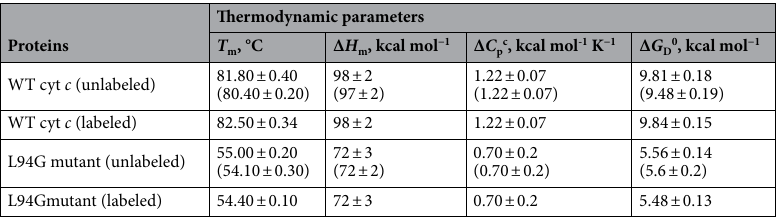
Table 3. Thermodynamic parameters associated with the heat-induced denaturation of WT cyt c and its L94G mutant in the native buffer (pH 6.0). a,b . a ± represents the deviation from the mean value of triplicate measurements. b In the presence of 30 mM sodium cacodylate and 100 mM NaCl (pH 6.0). c Values taken from 50,51 . Values in parenthesis are from DSC